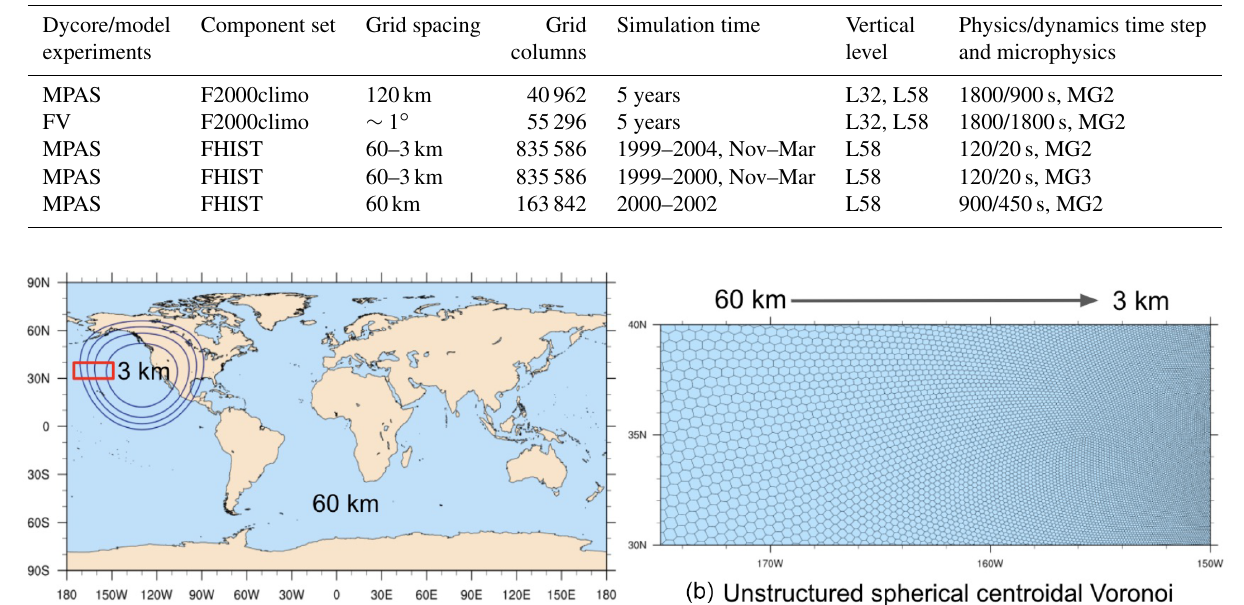
Table 1. A list of experiments in this study and the key configuration information.